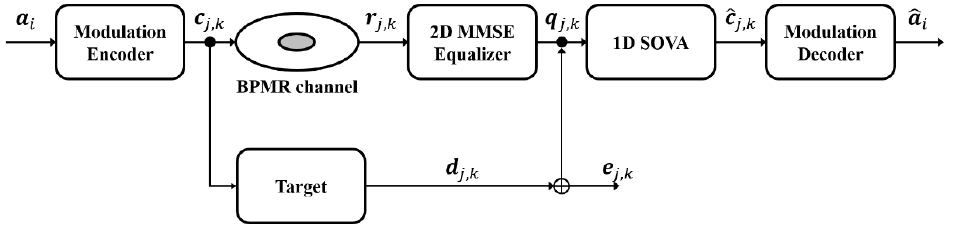
Figure 1. Block diagram of the BPMR system model.